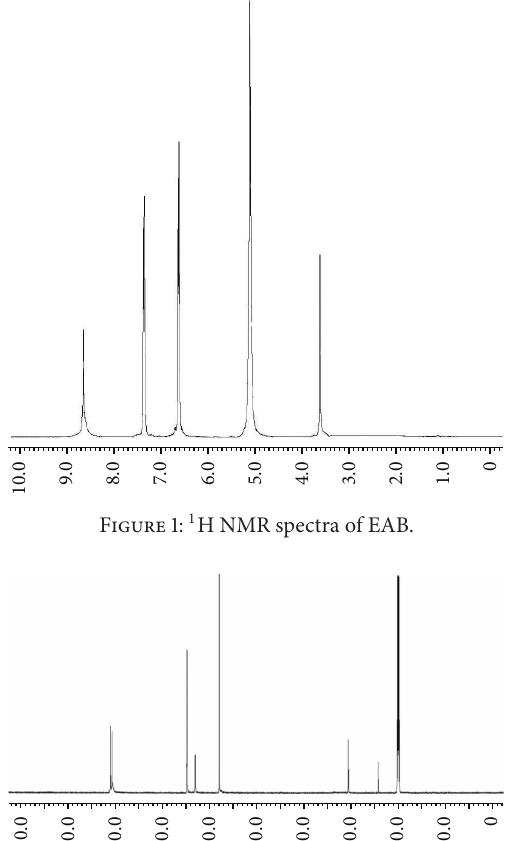
Figure 2: 13 C NMR spectra of